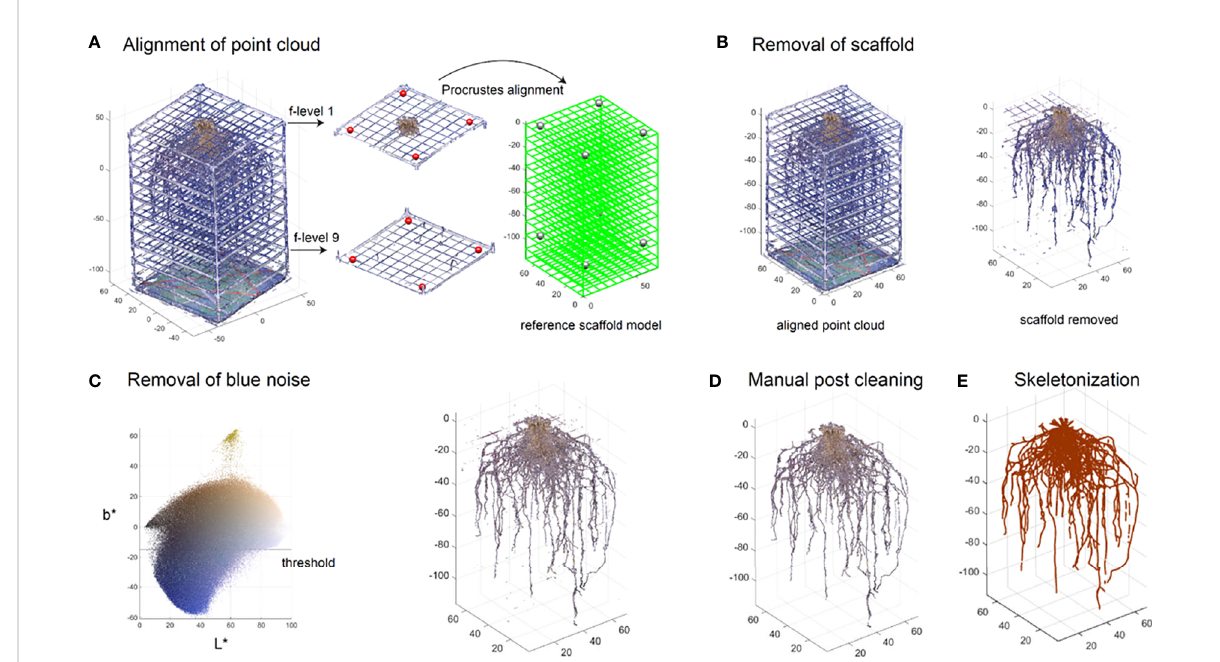
FIGURE 5 Semi-automated segmentation of the root system point cloud. Point cloud of the root system with the scaffold is aligned to a prede fi ned reference model by performing linear transform on manually picked target points to the control points (A) . Point cloud of the scaffold is removed based on the position and color information (B) . Blue noise on the root is then removed using a threshold method (C) . A post manual processing is conducted to further clean the root system point cloud (D) . Point cloud is skeletonized into a network system using an algorithm based on a Laplacian contraction method (E)